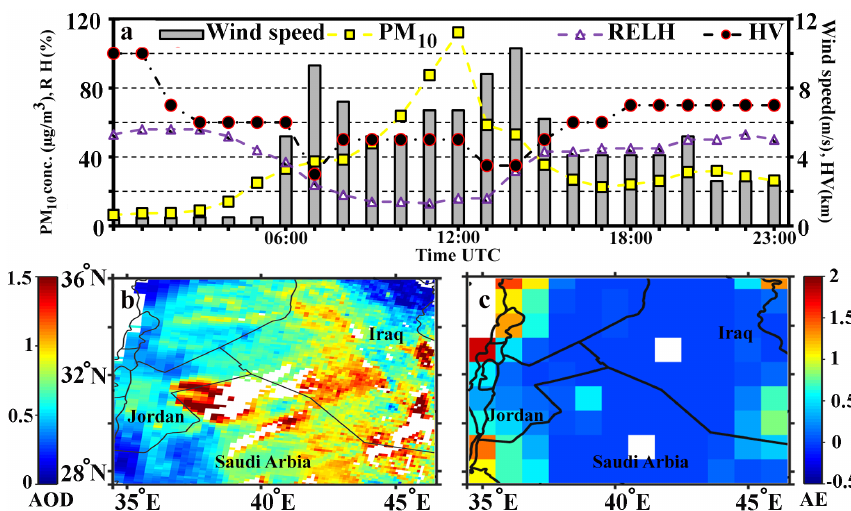
Figure 3. ( a ) Time series of the PM 10 concentration in addition to the surface wind speed, HV, and RH recordings on 7 June 2018. ( b ) Terra-MODIS with 10 km resolution (MOD04).( c ) Angström exponent (AE) with 1 degree resolution (MOD08 and